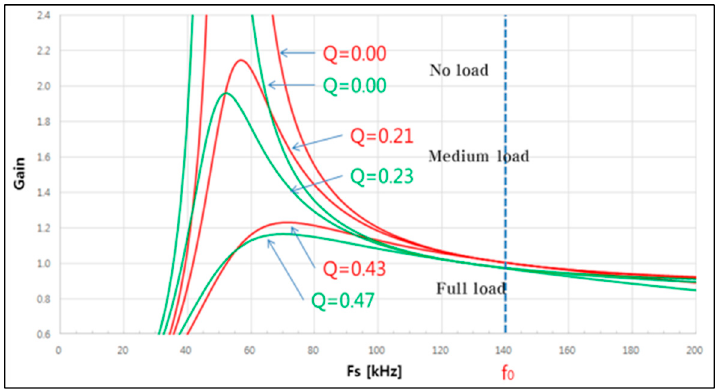
Figure 12. Input–output voltage gain and frequency characteristics of the auto-balancing converter. Electronics 2019 , 8 , x FOR PEER REVIEW